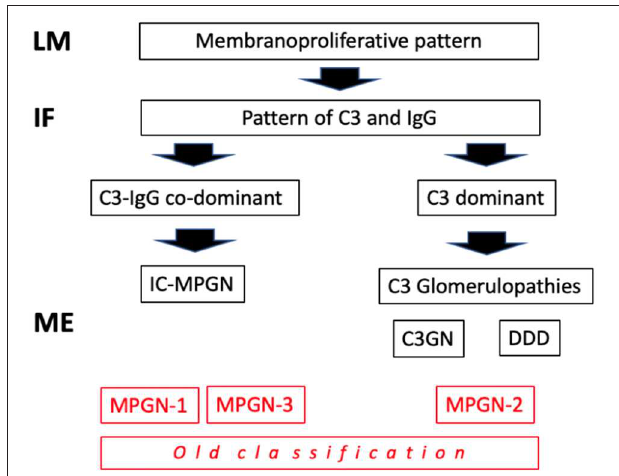
FIGURE 1 | Classification of mempranoproliferative glomerulonephritis based on IF pattern. LM: light microscopy; IF, immunofluorescence; EM, electron